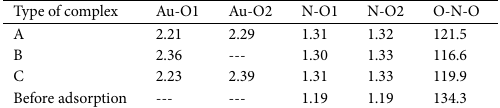
Table 1. Bond lengths (in Ǻ) for and angles (in degrees) of NO 2 molecule adsorbed on TiO 2 /Gold nanocomposites. Type of complex